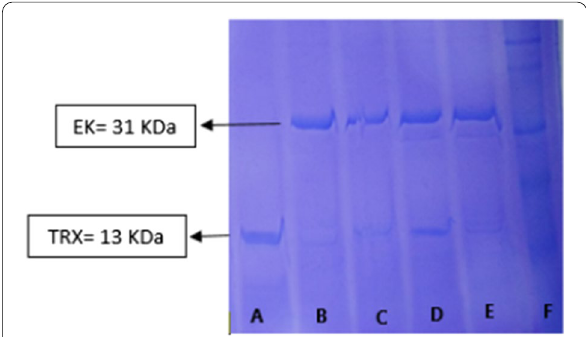
Fig. 2 Purification of separated TRX from the active enzyme by IDA affinity chromatography after the autocatalytic reaction. A fraction, B, C elution peak fractions, D,E = elution, F Pre-stained protein =